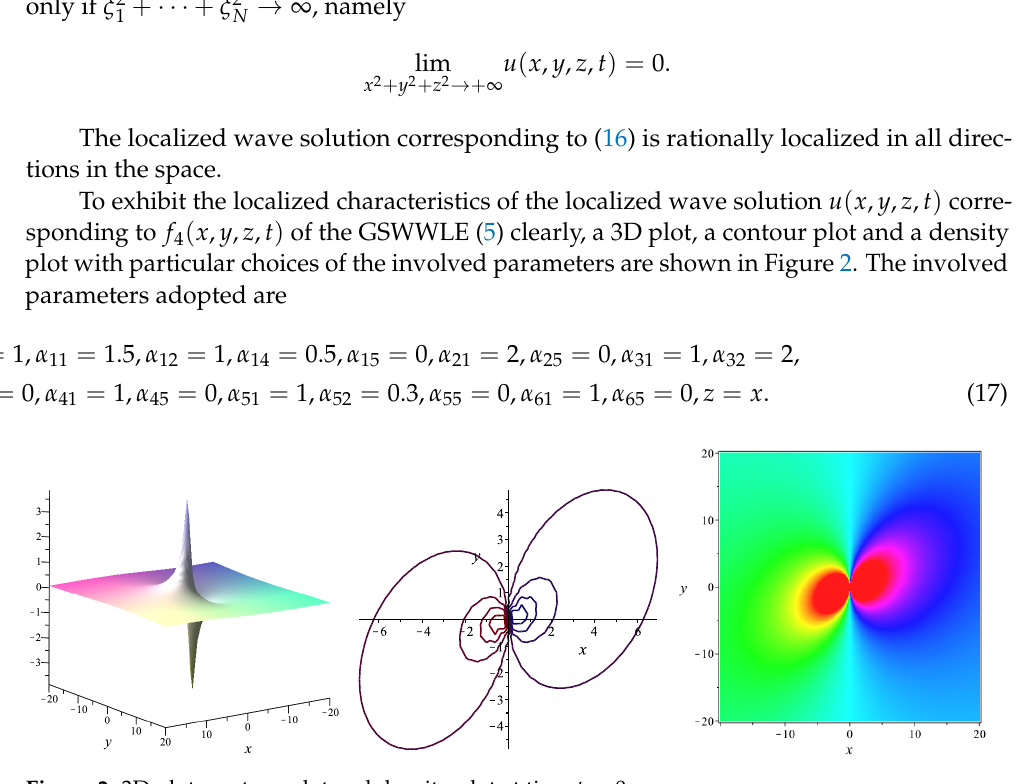
Figure 2. 3D plot, contour plot and density plot at time t =